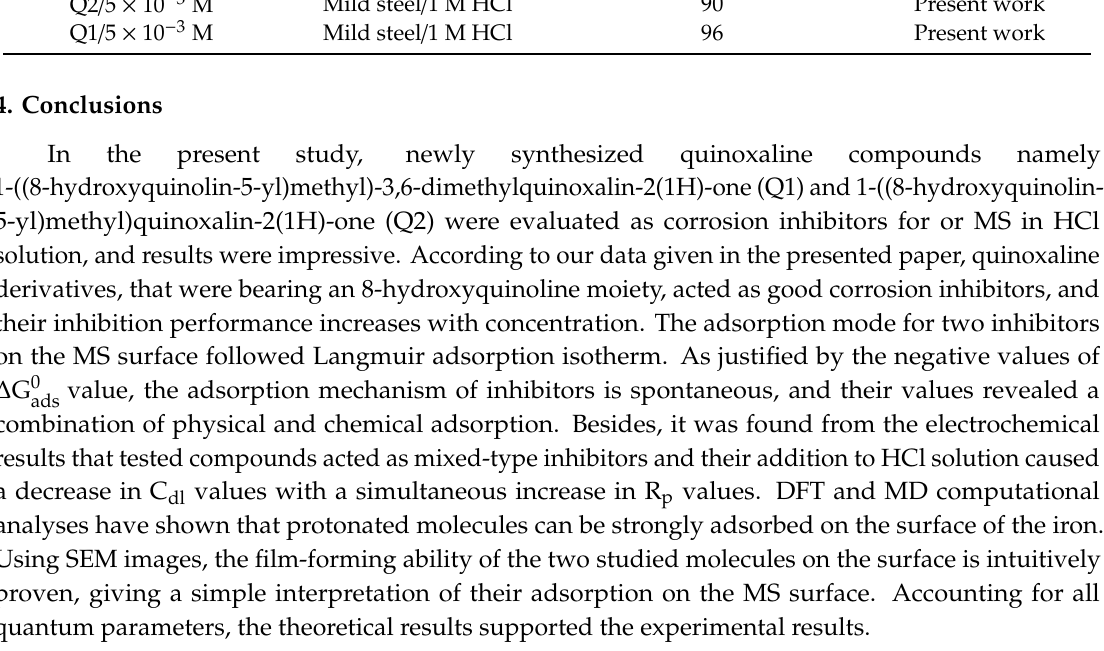
setup / Figure S1: Spectra IR, 1 H and 13 C NMR of compounds Q1 and Q2 / Figure S2: OCP–time plots of MS in 1.0 mol / L HCl with di ff erent concentrations of (a) Q1 and (b) Q2 at 303K / Figure S3: Equivalent circuit model applied to fit and simulate the impedance data / Figure S4: Adsorption isotherm models for the adsorption of Q1 and Q2 molecules on mild steel in 1.0 M HCl at 303 K (a) Langmuir, (b) Frumkin, (c) Temkin, and (d) Flory-Huggins / Figure S5: Langmuir adsorption isotherm models for the adsorption of Q1 and Q2 molecules on mild steel in 1.0 M HCl at di ff erent temperatures / Figure S6: Optimized structures, HOMO, LUMO and ESP of Q1 and Q2 in their neutral forms obtained by DFT / B3LYP / 6-31 + G(d,p) in aqueous solution / Figure S7: Side and top views of the final adsorption of Q1 and Q2 inhibitors in their neutral forms on the Fe (110) surface in presence of solvent species / Figure S8: Temperature and energy equilibrium curves of the investigated inhibitors adsorbed on the Fe (110) surface in solution / Table S1: Mulliken atomic charges for Q1 and